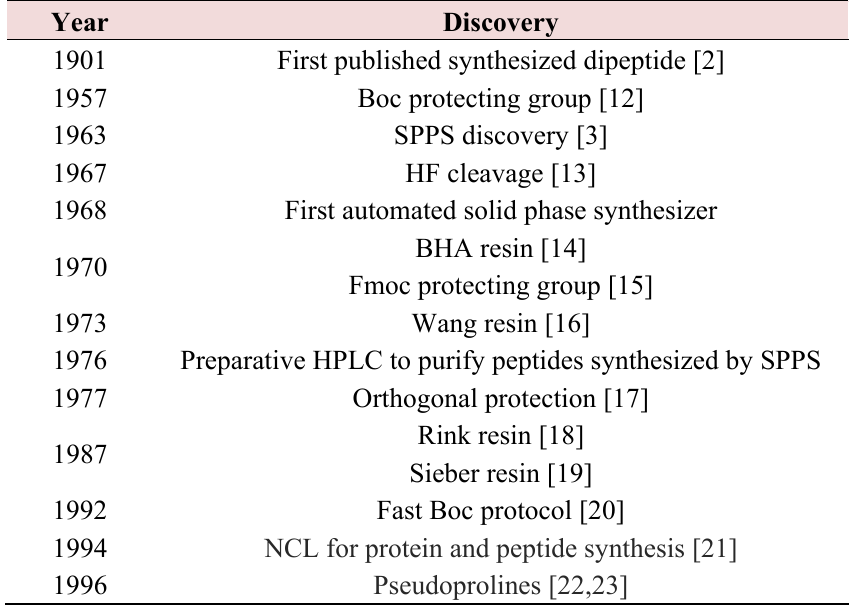
Table 1. Important dates in peptide